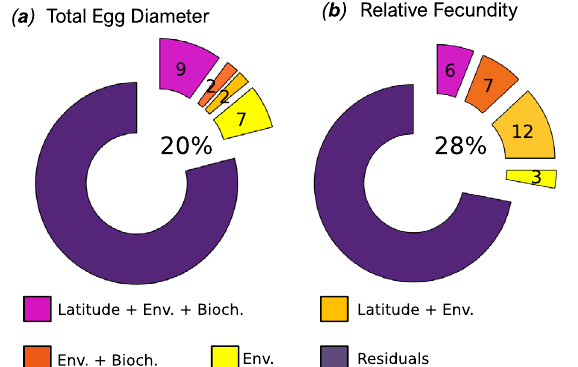
Figure 3. RDA variance partitioning of among-female egg size and relative fecundity during winter 2018. Numbers indicate R adj2 values. Only the non-null fractions and residuals are represented. The four non-null fractions were: ( a ) environmental predictors alone (Env.), ( b ) the shared effect of environmental predictors with latitude (Latitude + Env.), ( c ) the shared effect of biochemical and environmental predictors (Env. + Bioch.) and ( d ) the shared effect of biochemical and environmental variables together with latitude (Latitude + Env. + Bioch). Latitude is linear for total egg diameter, and quadratic for relative fecundity. Environmental variable selection for each trait was based on the RDA analysis presented in Fig.